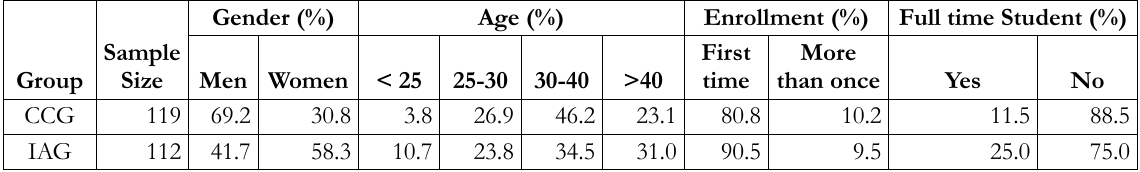
Table 1. Demographic description of the studied